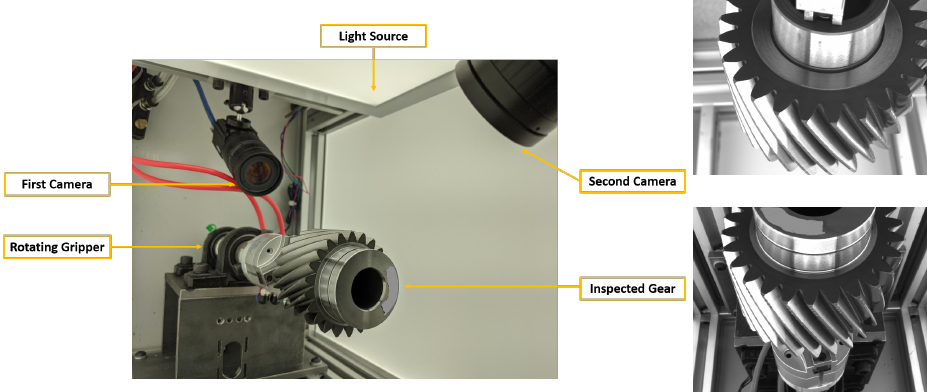
Figure 4. Inspection cell and sample camera images. Left : inspection cell, Top Right : image from the first camera, Bottom Right : image from the second